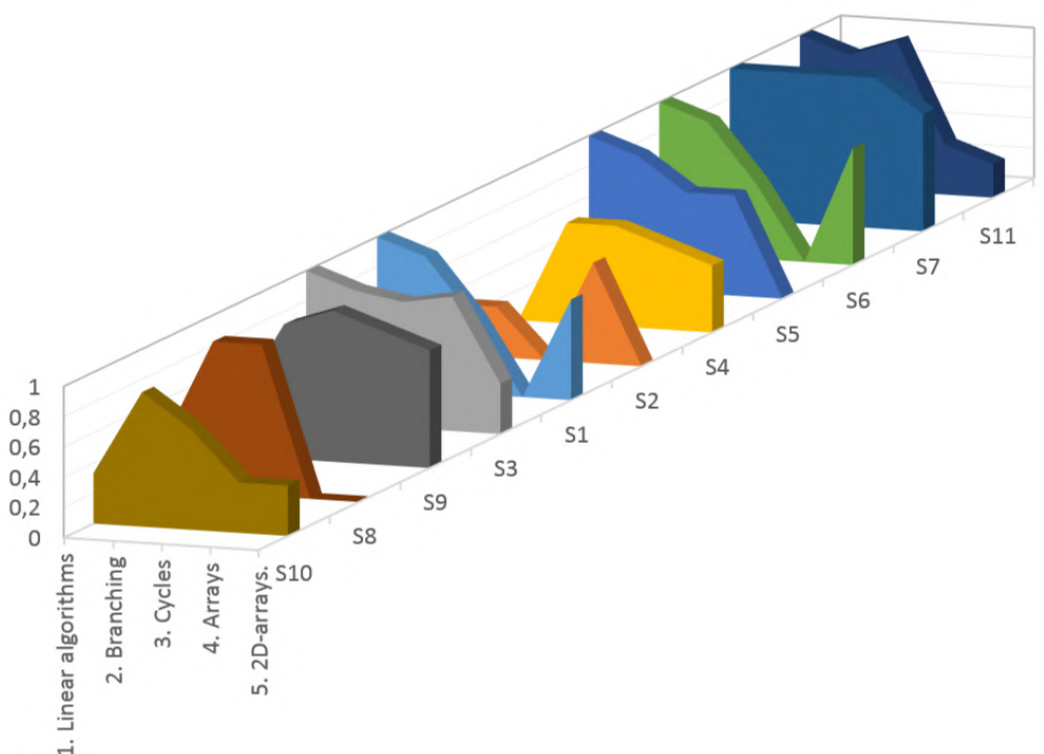
Figure 56: Presentation of paper